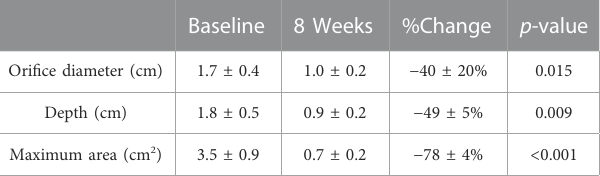
TABLE 2 Dimension of LAA (measured by TEE). After the LAA inversion procedure, the ori fi ce diameter, depth, and maximum area of LAA were all signi fi cantly reduced at 8 weeks compared to baseline ( p < 0.01, t-test). % Change = (8 weeks data – baseline data)/baseline data x